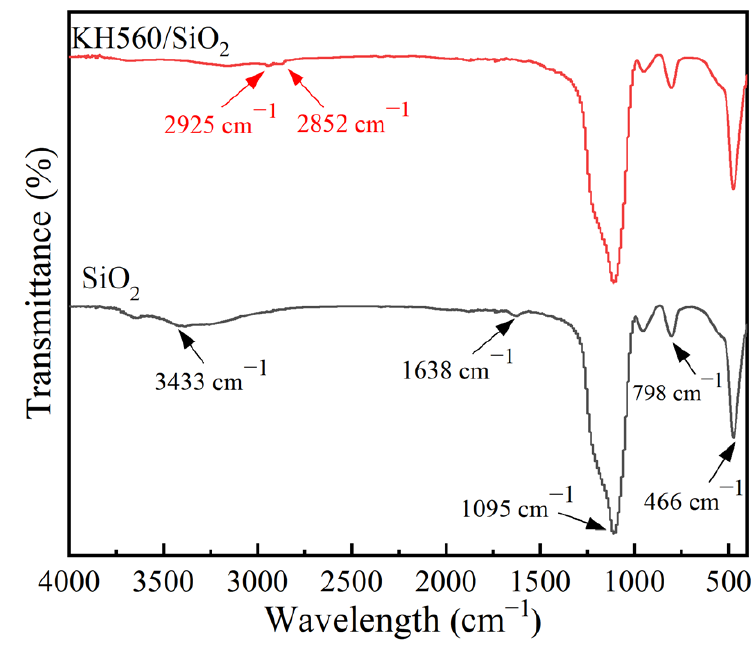
Figure 2. FT-IR patterns of SiO 2 and KH560/SiO 2 .